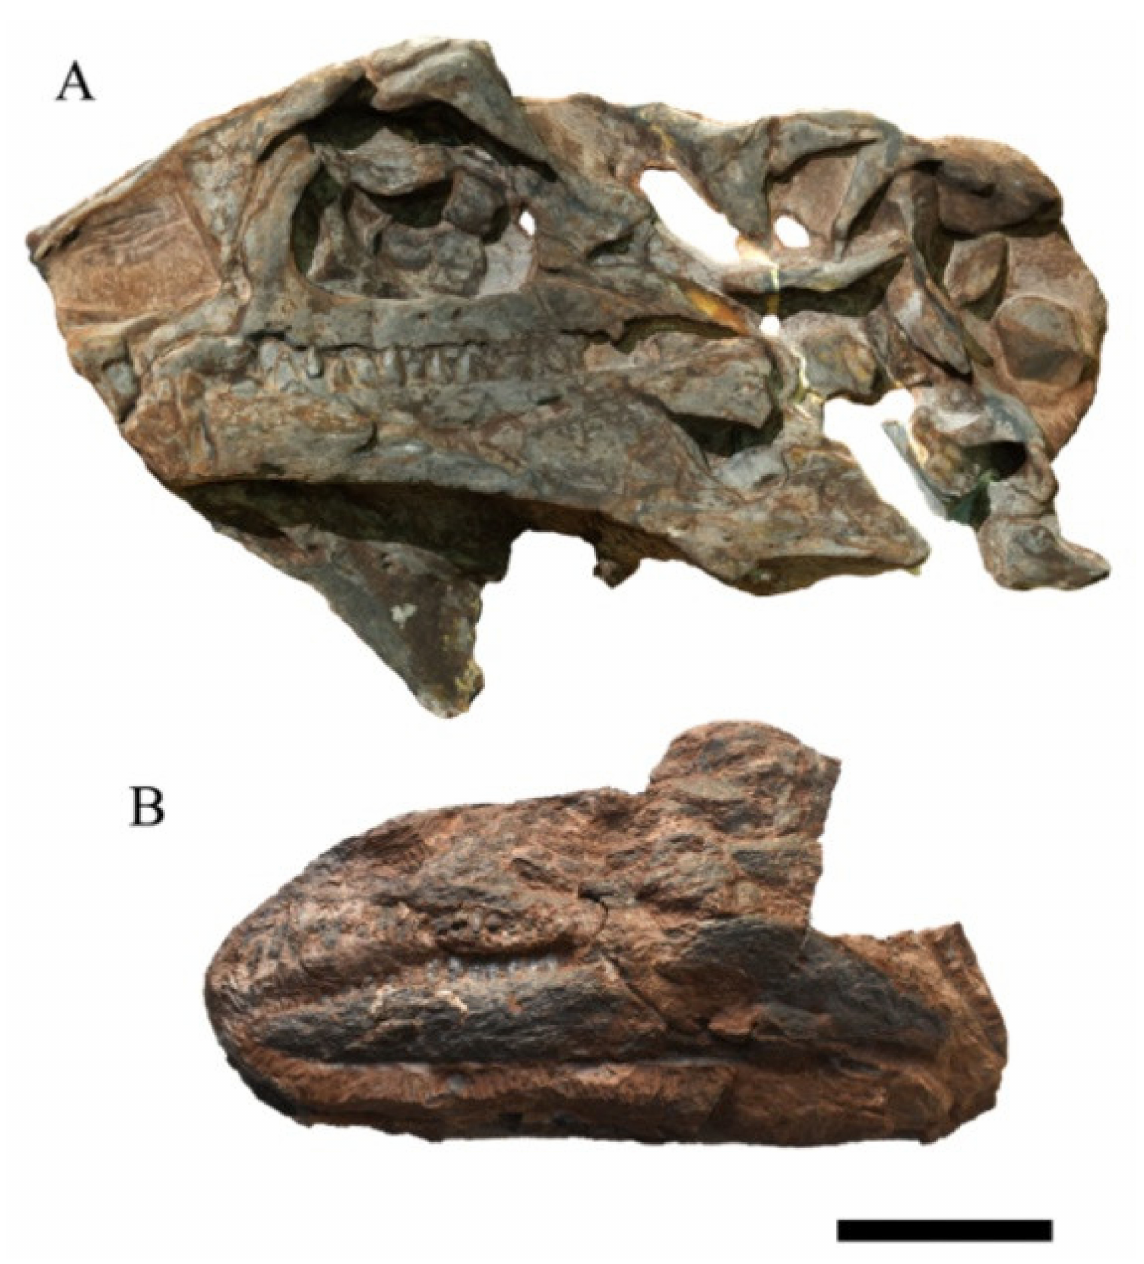
Figure 3. Photograph of the skulls NHMD 164741 and NHMD 164758. ( A ) NHMD 164741 in left lateral view. ( B ) NHMD 164758 in left lateral view. Table 1. List of specimens used in this study for purposes of comparative